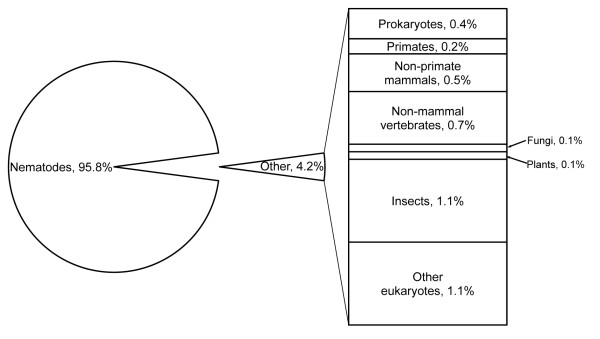
Categories of organisms with significant protein matches of H. bacteriophora distinct ESTs. The percentage was calculated considering the total number of H. bacteriophora distinct ESTs having significant matches (E value < 1e-5) as 100%.